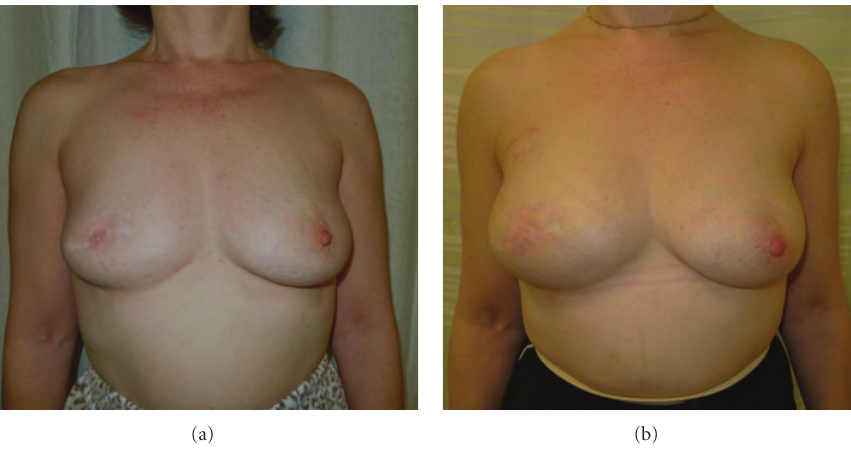
Figure 1: (a) This patient had previously undergone a central wide local excision and nipple reconstruction at the age of 47. Although the contour of the right breast is similar to that of the left, there is a relative lack of projection and the breast has a blunted appearance. (b) Autologous fat transfer, in the form of lipomodelling, successfully fills the defect from previous surgery. The patient also received a subdermal silicone areola prosthesis to improve projection of the reconstructed nipple.